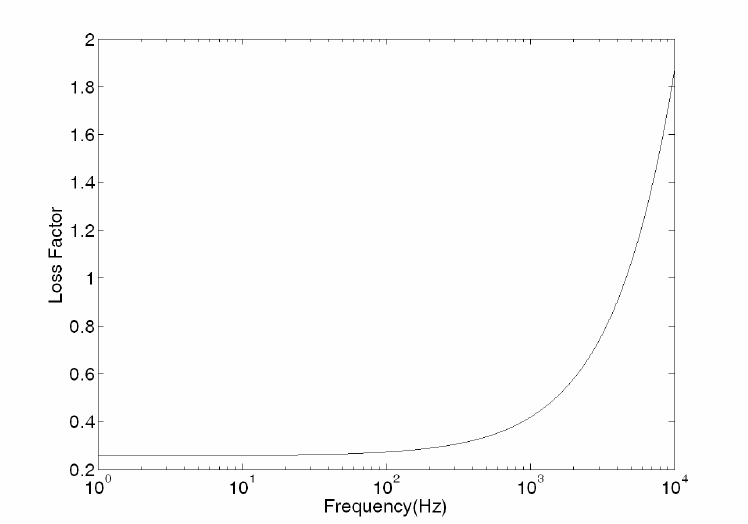
Fig. 9. The frequency-dependent loss factor.